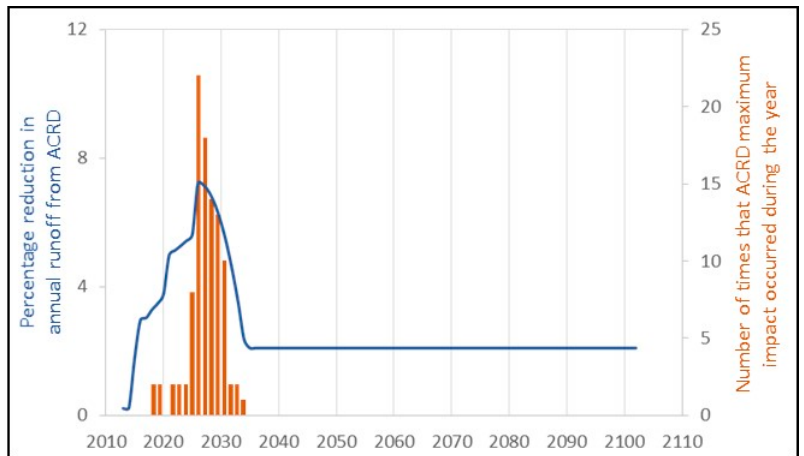
Figure 11. Number of times (in the 100 stochastic simulations) that the maximum ACRD impact on annual runoff at Node 14 occurred during the different years.